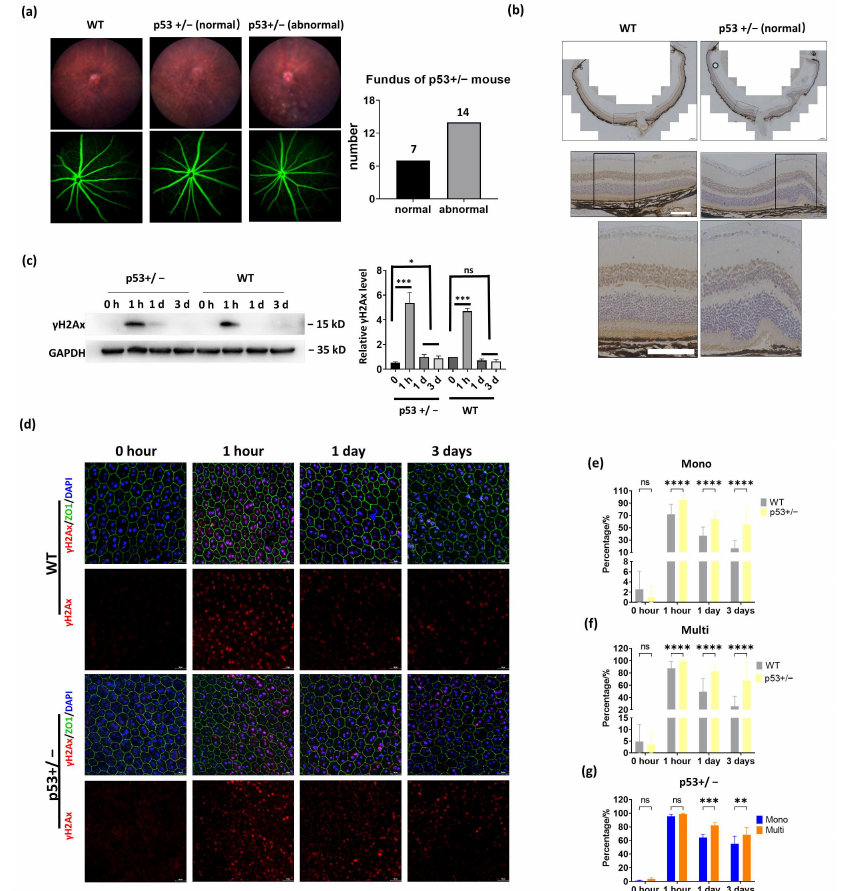
Figure 5. Induction of DNA damage in WT and p53+/ − mouse retina. ( a ). Left: fundus photography (upper panels) and fluorescein angiography (lower panels) were performed to analyze WT and p53+/ − mice eye morphology. Right: quantification results of the normal and abnormal eye fundus photography from p53+/ − mice. ( b ). IHC of rhodopsin shows RPE and retina morphology in WT and p53+/ − mice. Scale bar: upper: 200 µ M, middle and bottom: 100 µ M. ( c – g ). The WT and p53+/ − mice were subject to 1 Gy of IR, and retinas or RPE cells were collected at the indicated time point post-IR. ( c ) WB analysis shows relative the indicated protein levels in mouse retinas. Right panels: the relative γ H2Ax level was obtained by normalizing with GAPDH. ***: p < 0.001, ns: not significant. ( d ). Comparison of DNA damage response in WT and p53+/ − RPE. IF analysis of γ H2AX staining at the indicated time point post-IR. The cell cytoskeleton F-actin was labeled by FITC-phalloidin staining. Scale bar: 20 µ m. ( e – g ). Quantitative analysis of the γ H2AX-positive RPE cells in WT and p53+/ − mice. WT: n = 4, p53+/ − : n = 3. Total of 40 regions of WT group and 30 regions of p53+/ − group were randomly selected, and the γ H2AX-positive cells were counted and quantified. * p < 0.05, ** p < 0.005, *** p < 0.001, **** p < 0.0001, and ns: not significant. All data are shown as mean ±